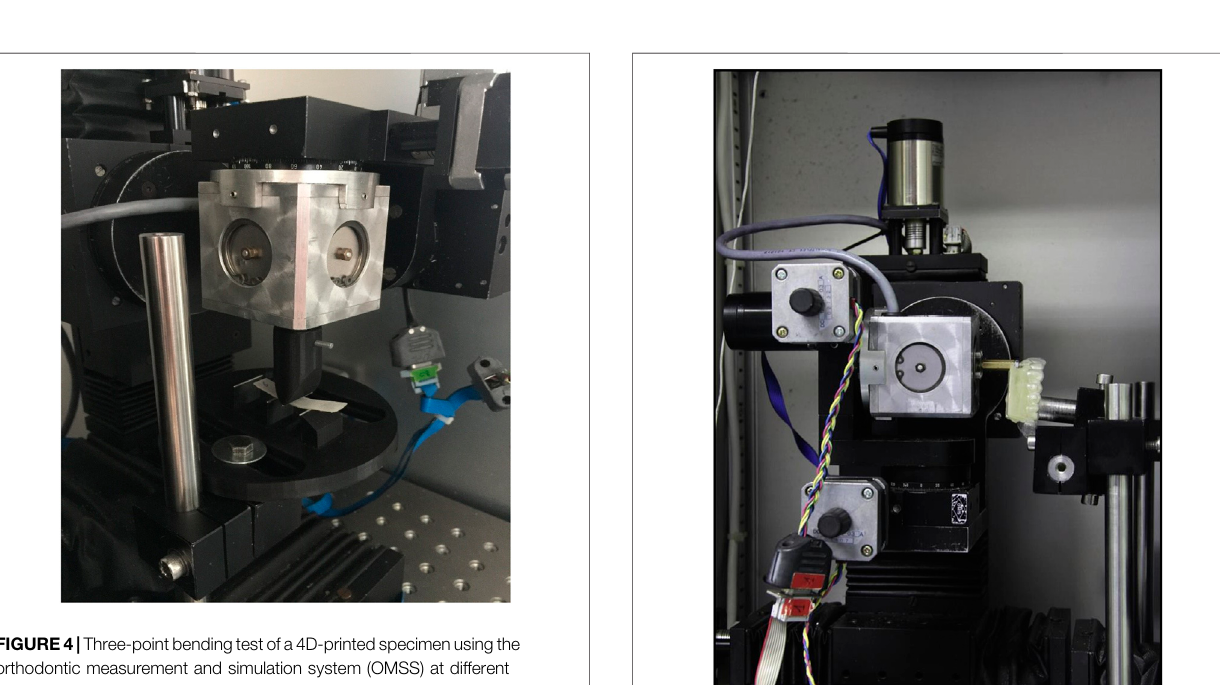
FIGURE 3 | A schematic diagram illustrating the main steps of the ClearX 4D aligner method.